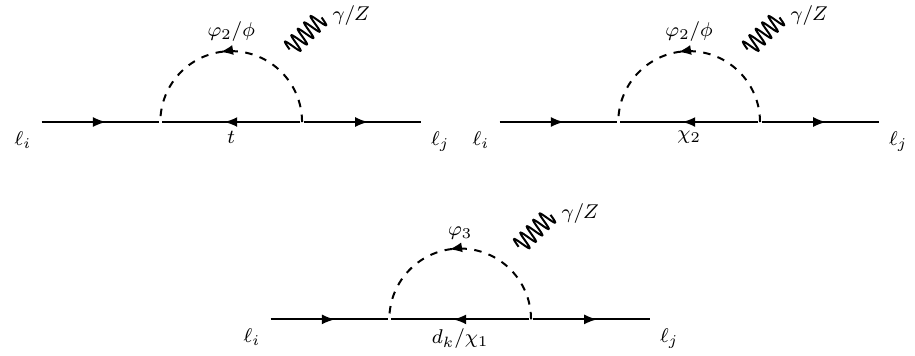
Figure 11. Contributions to ‘ i ! ‘ j (cid:13) processes, where additional splitting of the boson line gives contributions to ‘ i ! ‘ j ‘ k ‘ k . The photon/ Z can be attached to any of the four